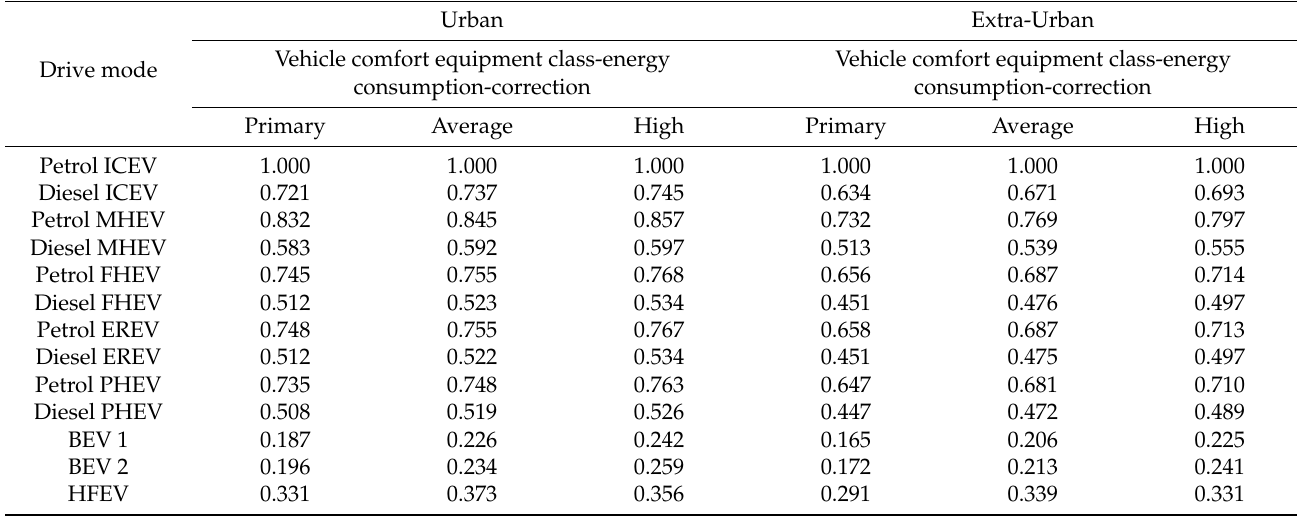
Table 2. Coefficients correcting the energy consumption in comparison with ICEV vehicles (spark-ignition and compression- ignition engines).